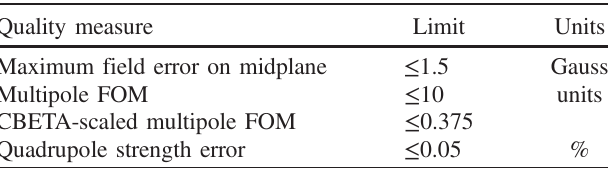
TABLE II. Quality measures used for magnet acceptance.